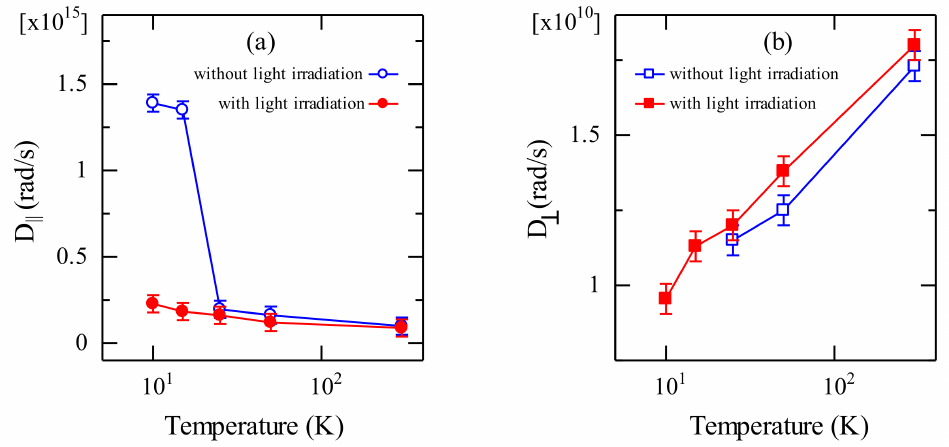
Figure 6. Temperature dependence of the diffusion rates in regio-regular P3HT–ZnO nanoparticles: ( a ) parallel and ( b )